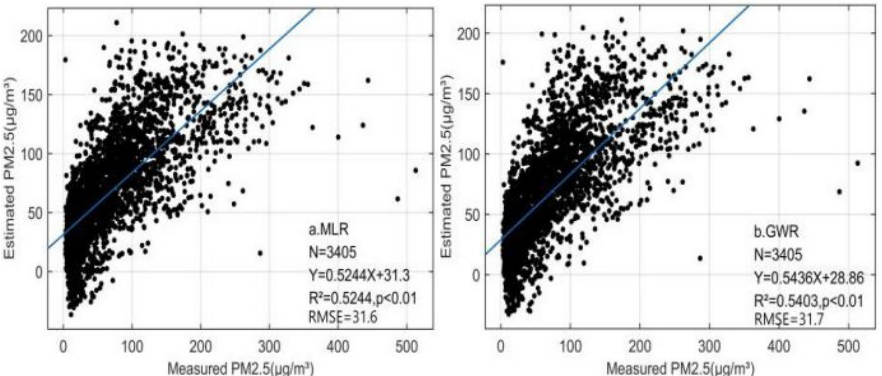
Figure 3. Multiple linear regression (a) and geographically weighted regression (b) fitting results (N = 3405) The average values of the regression coefficients of the statistical MLR model and the GWR model were shown in Table 3. From the table, the regression coefficients of the two models were generally close. The PM2.5 mass concentration